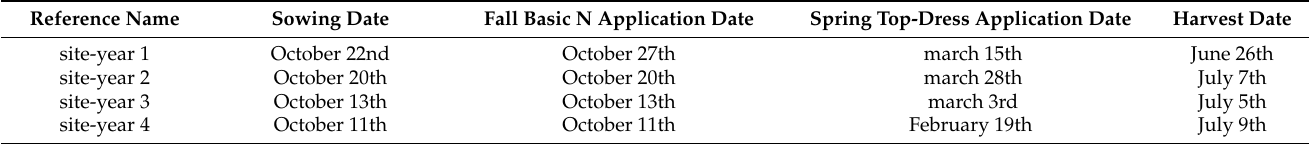
Table 2. Sowing dates, fertilizer application dates and harvest dates for the four site-years of the study.